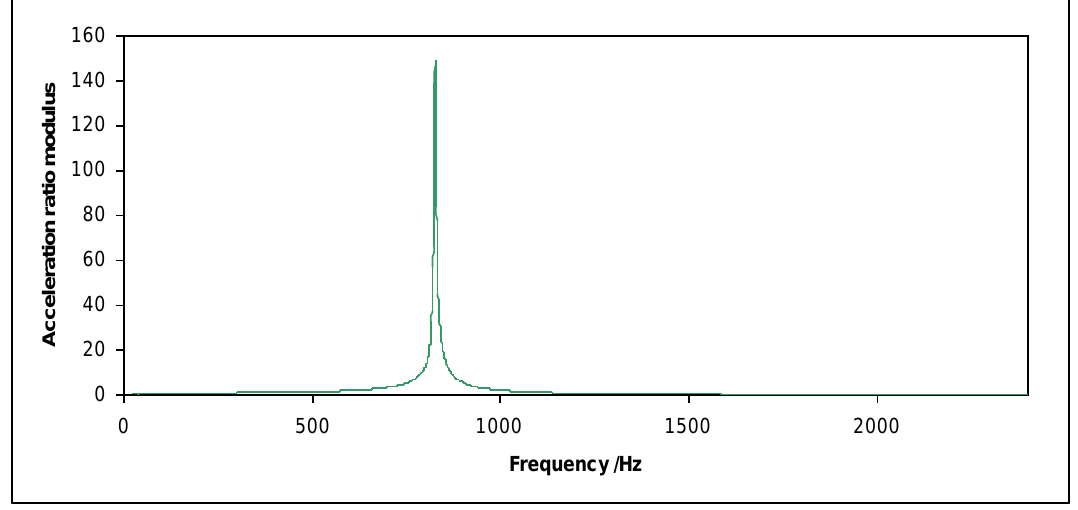
Figure 2. Acceleration ratio modulus for the Kistler 9175B sensor (12.3 kg loading mass).